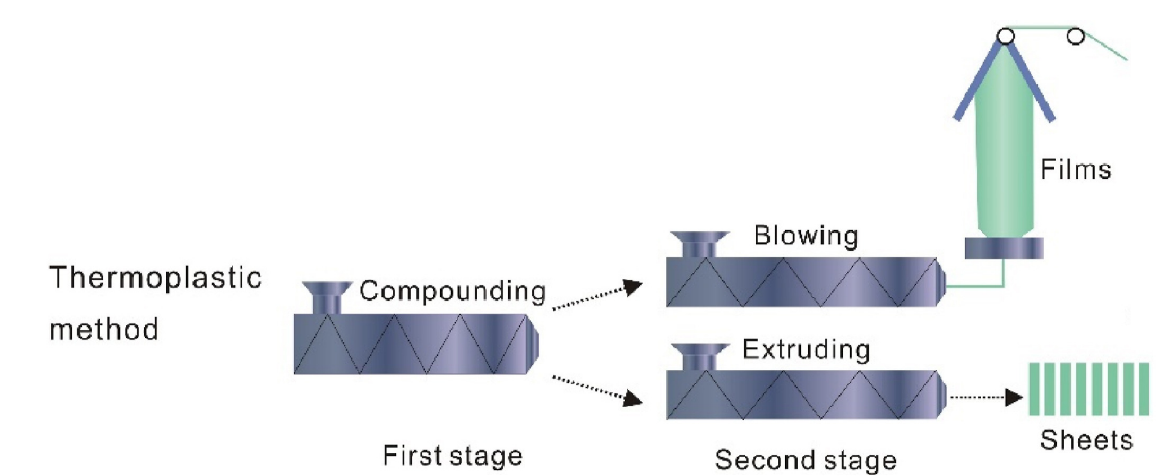
Figure 13. Schematic of film production by extrusion method (taken from [24]).